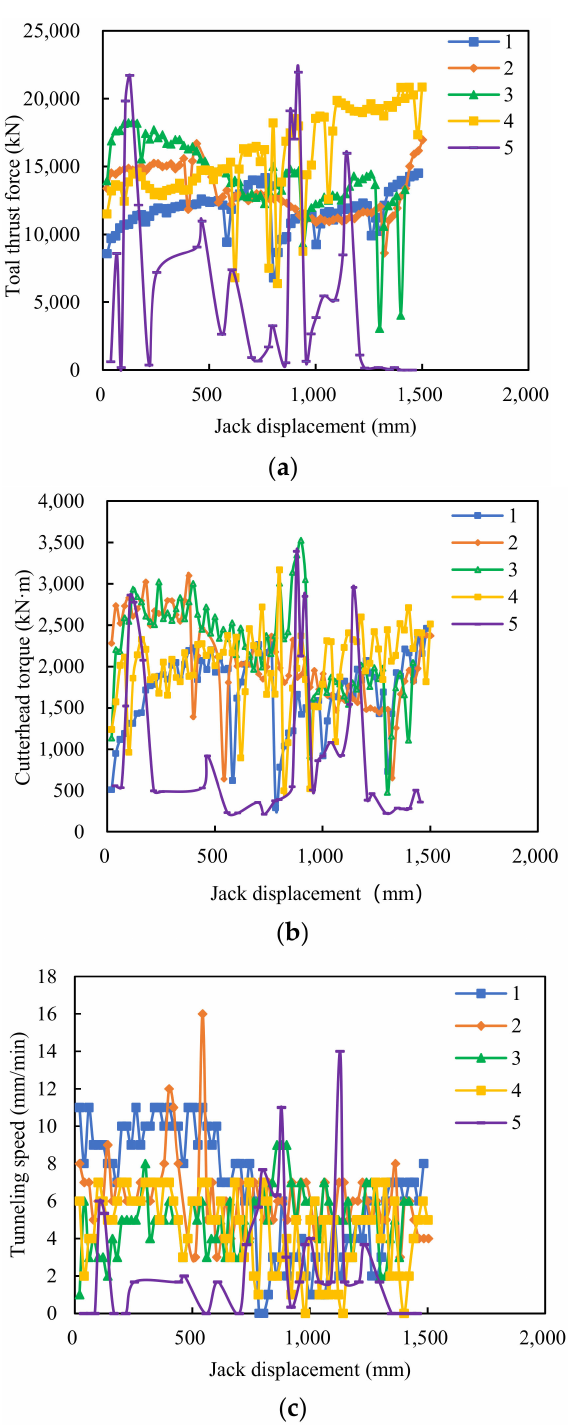
Figure 4. Variation in the tunneling parameters with jack displacement; ( a ) Variation in the total thrust force with jack displacement. ( b ) Variation in the cutterhead torque with jack displacement. ( c ) Variation in the tunneling speed with jack